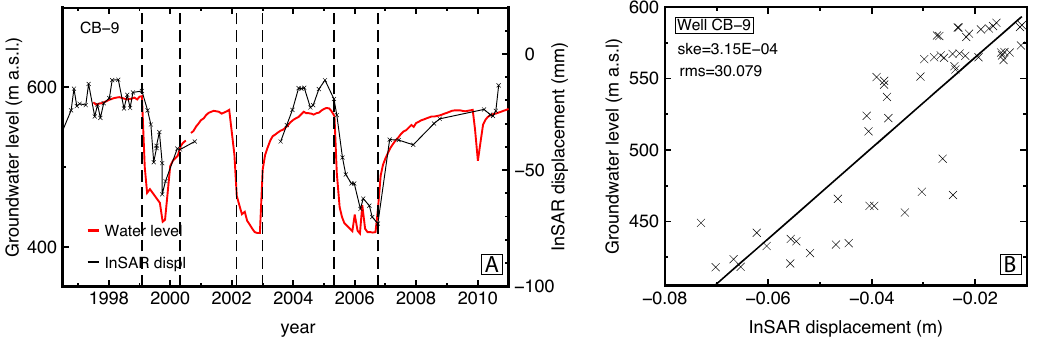
Figure 2. Estimation of skeletal elastic storage coefficient from stress displacement analysis for well CB-9 (see location in Fig. 1). On the left, InSAR displacement and piezometric time series On the right, stress-strain diagram. Vertical dashed lines represent dates limiting water extraction cycles.